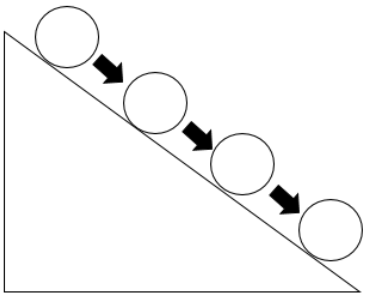
Figure 2. Ball and Slope Illustration.